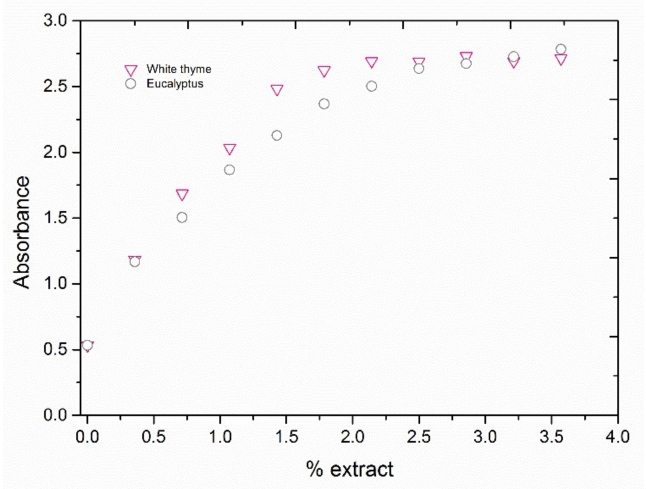
Figure 3. Influence of extract percentage in silver NPs’